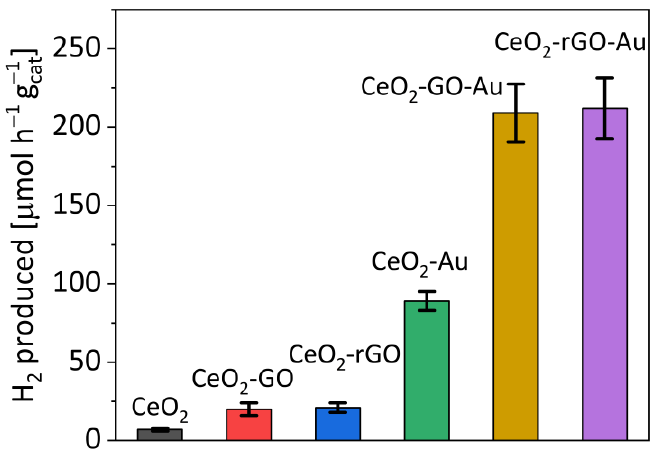
Figure 2. H2 production over the different CeO 2 -based Figure 2. H 2 production over the different CeO 2 -based samples.